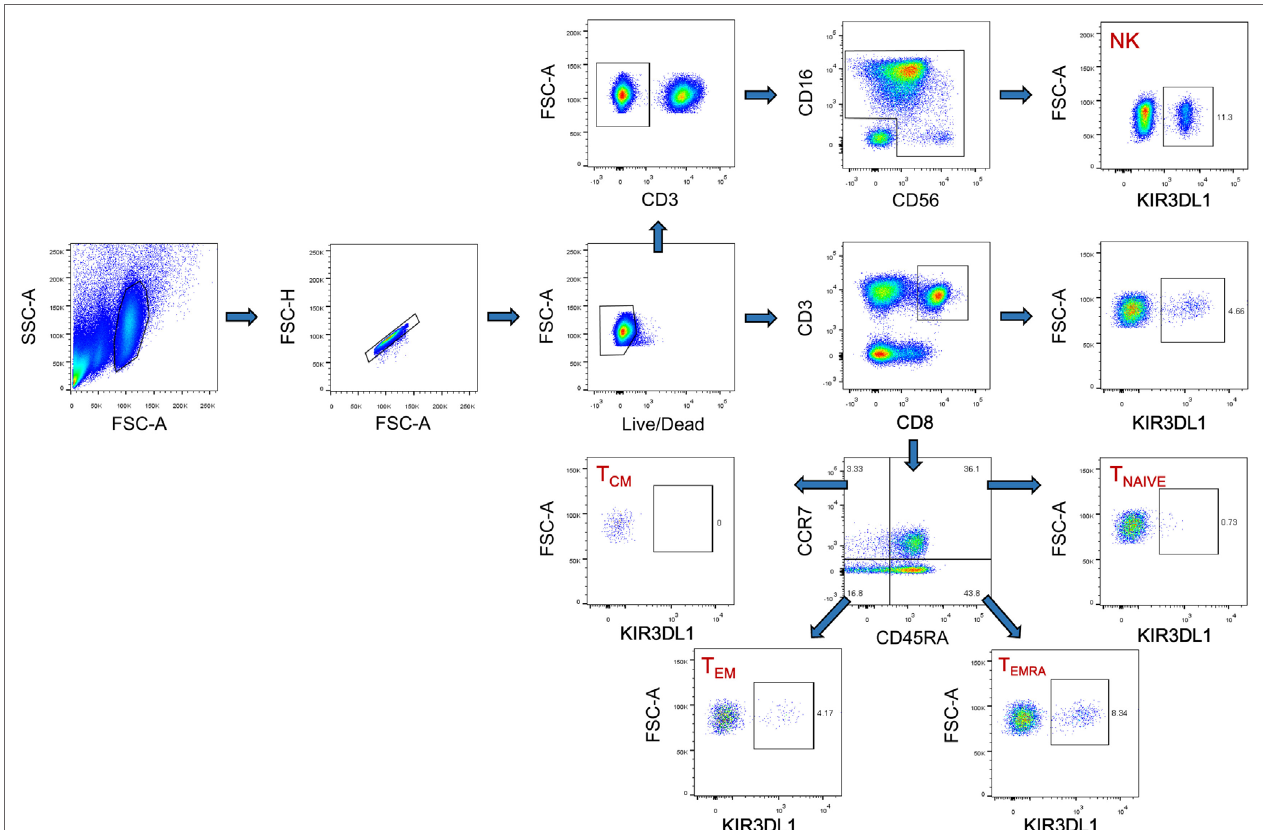
FigUre 1 | The gating strategy for flow cytometric analysis of KIR3DL1 expressing on CD8 T cells and NK cells. Among all events, forward angle and SSC light gating were gated on lymphocytes and were used to exclude cell debris from the analysis. Forward height and forward area were used to exclude doublet cells, and cells were labeled with Live/Dead fixable viability stain 510, and dead cells were excluded. Then CD3 + CD8 + T cells, KIR3DL1 + CD8 + T cells, CD8 + T cell subsets (T NAIVE , T CM , T EM , and T EMRA ), and KIR3DL1 expressing on different CD8 + T cell subsets were gated; CD3 − cells, CD16 + CD56 + NK cells, and KIR3DL1-expressing on NK cells were also analyzed simultaneously. The final analysis was performed with FlowJo software, which generated a graphical output. FSC, forward scatter; SSC, side scatter; NK, natural